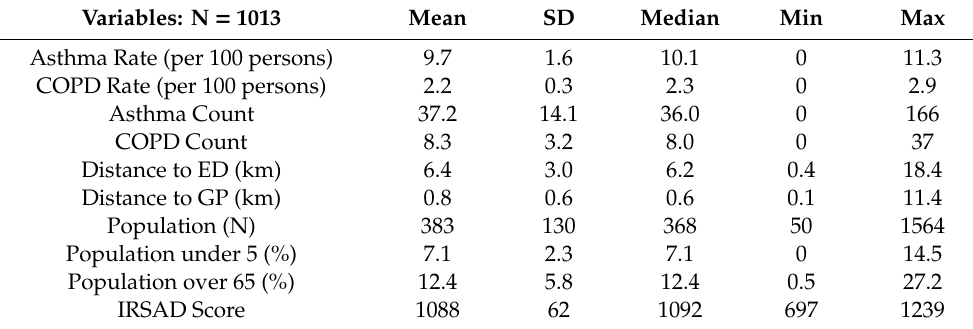
Table 2. Summary statistics of modelling